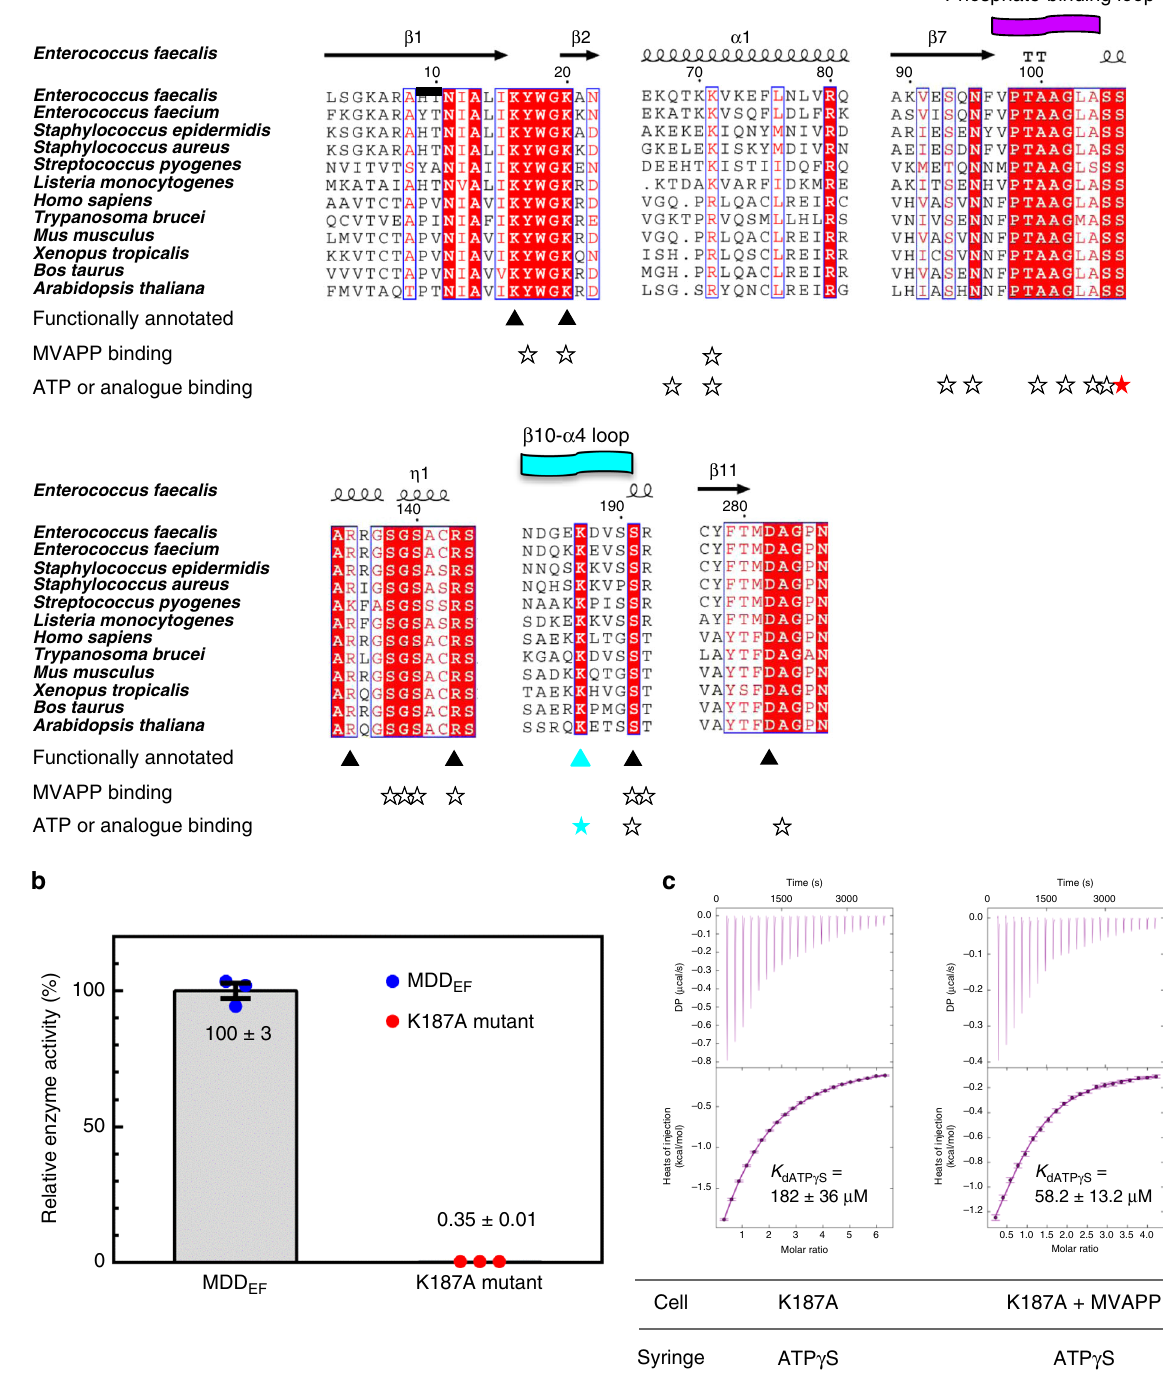
Fig. 6 The key residue, K187, involved in enzyme catalysis. a Partial sequence alignment results of the MDD family of proteins (see “ Methods ” section for details). Identical residues are highlighted in red. Homologous residues have their one-letter codes in red. Residues characterized to be functionally important among MDD proteins are marked by solid triangles 17,18,40 . Residues involved in substrate interaction are marked by empty stars and color- fi lled stars (red: S106; cyan: K187). The phosphate-binding loop and the β 10- α 4 loop are indicated with curved ribbons in magenta and cyan, respectively. b Relative enzyme activity of the K187A mutant and the wild-type MDD EF . The enzyme activities of MDD EF and K187A mutant of MDD EF were determined at saturating concentrations of two substrates (MVAPP = 200 μ M; MgATP = 800 μ M) and normalized by the means of wild-type MDD enzyme activity ( n = 3 independent experiments). The means and the standard error (SEM) were derived from each triplicate. Source data are provided as a Source Data fi le. c ITC experiments of MDD μ M) was titrated with ATP γ S (3 mM). Right: the K187A mutant EF and the K187A mutant. Left: the K187A mutant (100 (100 μ M) was pre-incubated with MVAPP (1 mM) and then titrated with ATP γ S (2 mM). The thermodynamic parameters of each experiment are listed in Supplementary Table 6. The protein concentration was adjusted to 100 μ M and all the protein and titrants were dissolved in the buffer containing 100 mM HEPES, pH 7, 100 mM KCl and 10 mM MgCl 2 . Error bars in b and c represent standard error of the mean